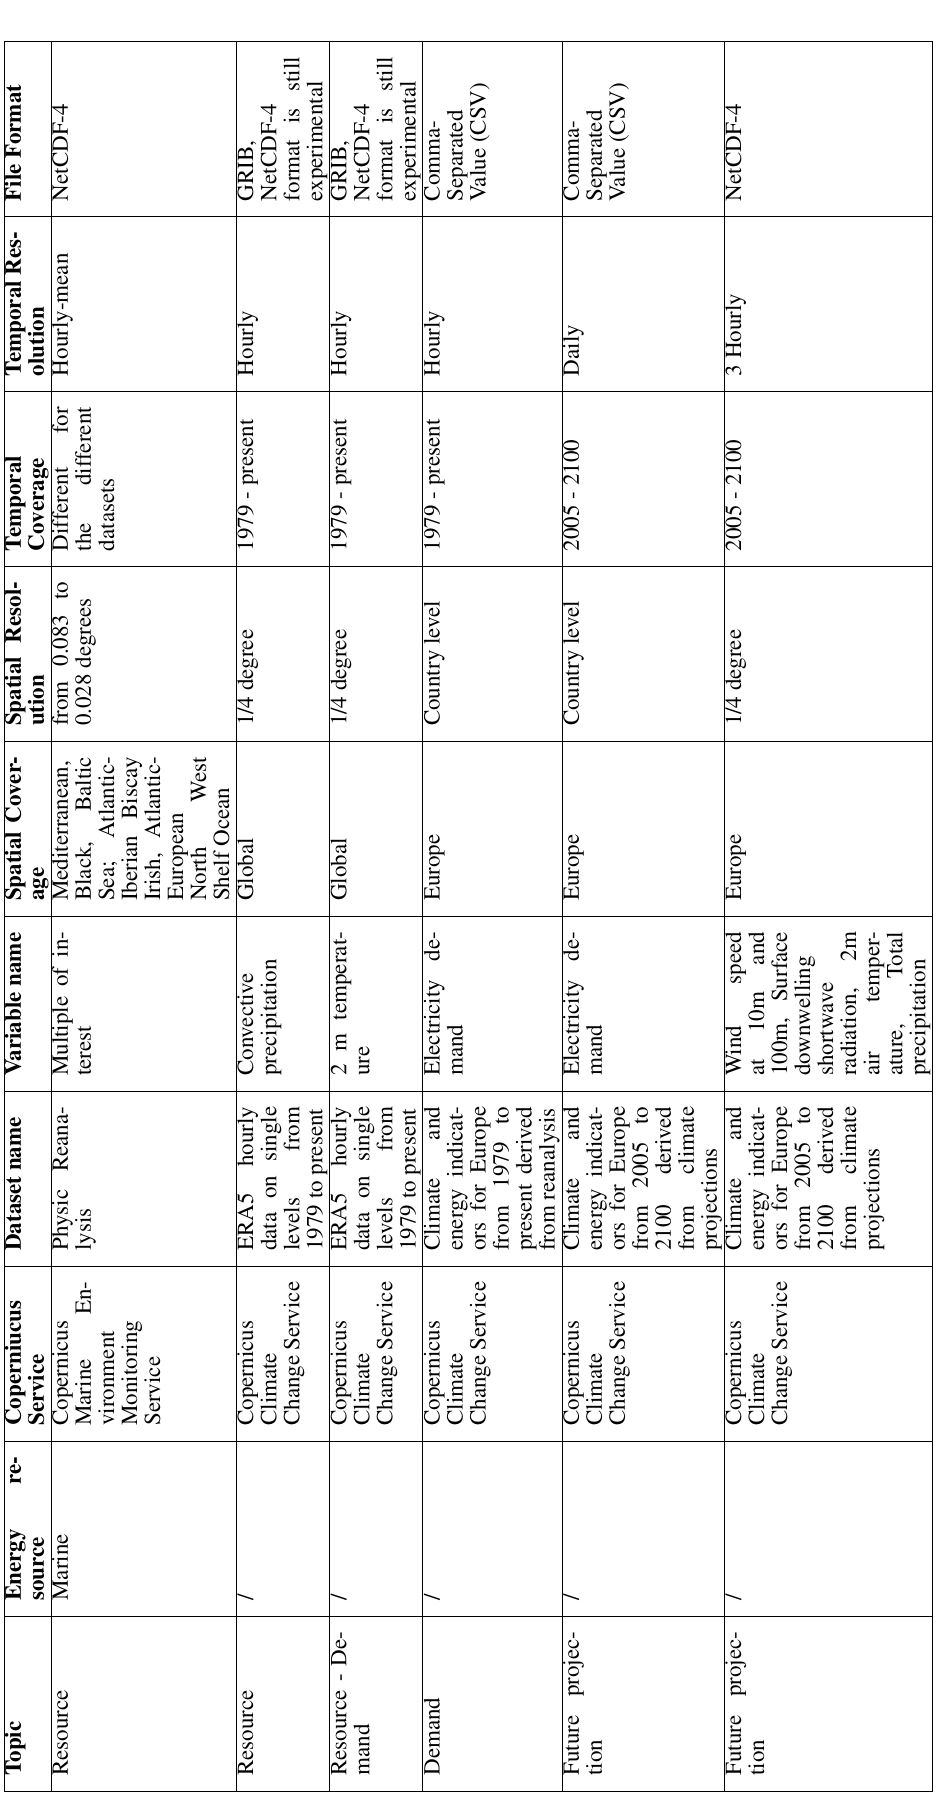
Table 2b. Datasets of interest for the energy